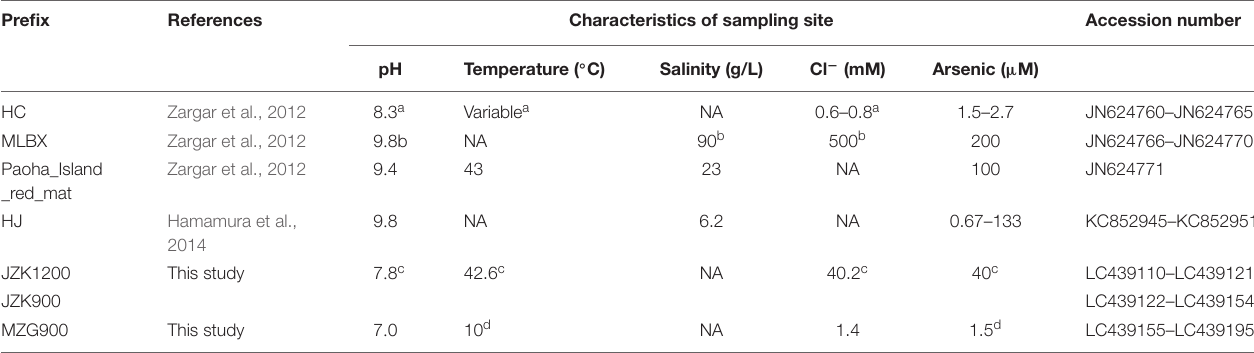
TABLE 1 | Partial arxA gene sequences of uncultured organisms included in phylogenetic analysis in this study ( Supplementary Figure S8 ).